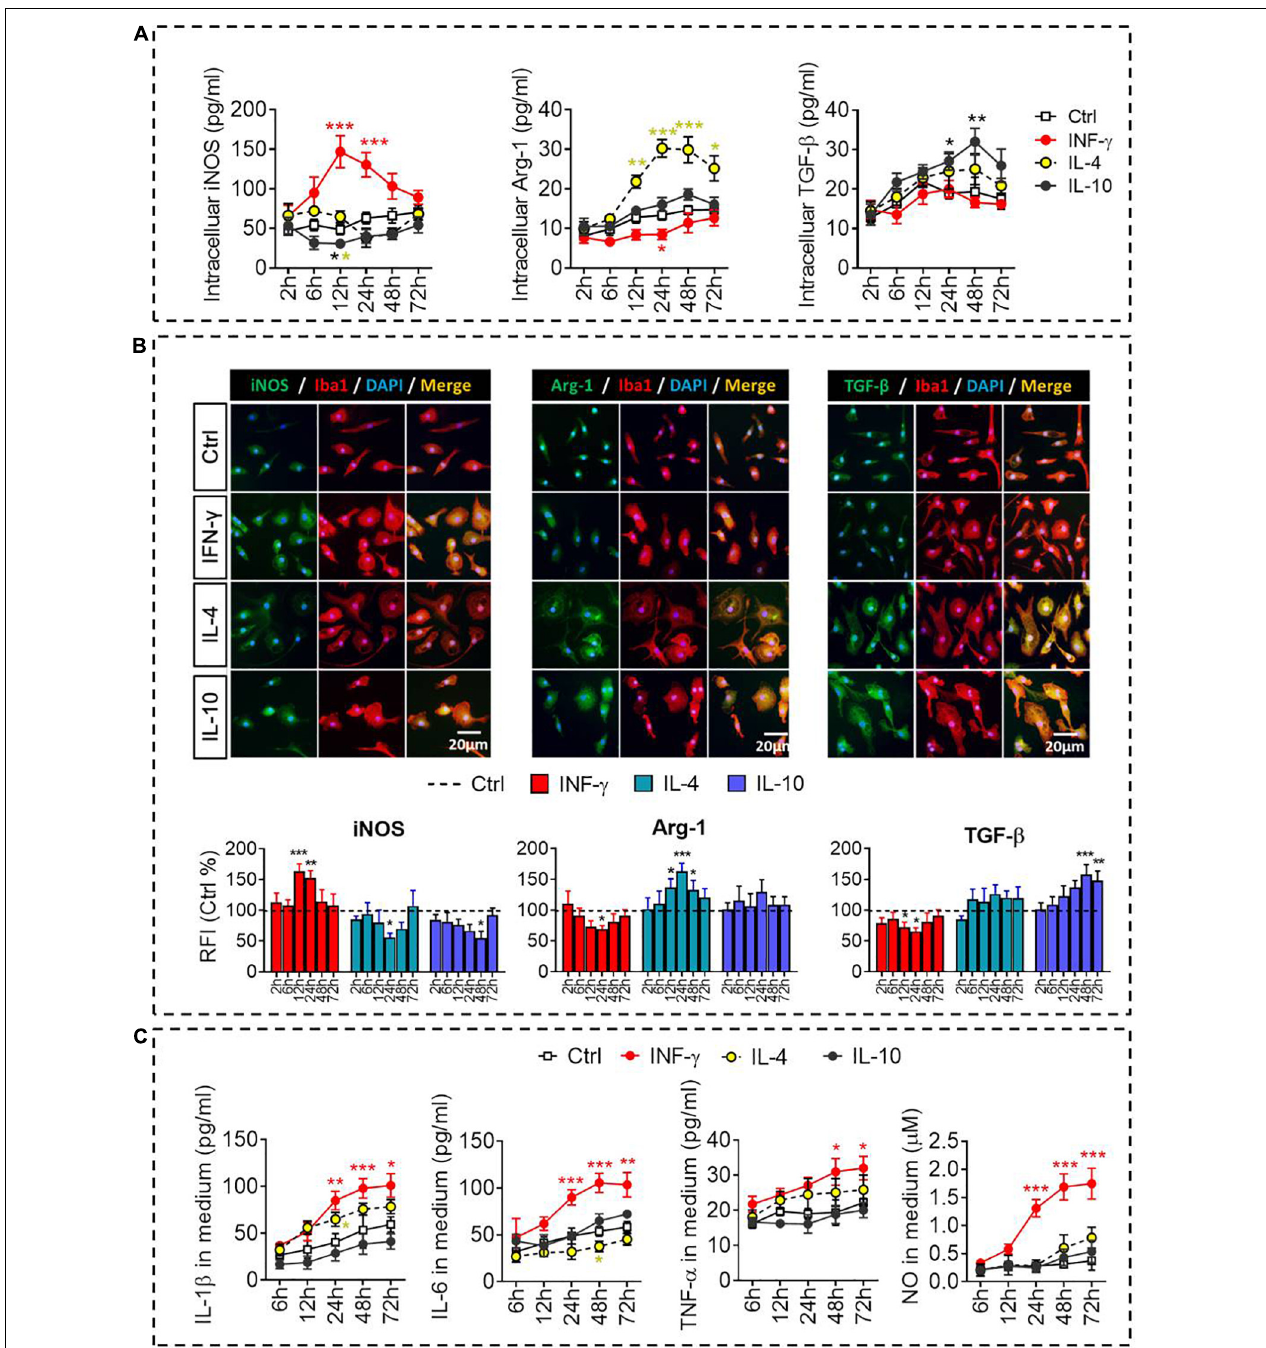
FIGURE 3 | Identification of intracellular and extracellular proteins in IFN- γ -, IL- 4-, or IL-10-stimulated microglia. (A) Quantification of the intracellular protein concentration of iNOS, Arg-1, or TGF- β following treatment with IFN- γ , IL-4, or IL-10 for 2–72 h. (B) Fluorescence micrographs of primary microglial cultures treated for 24 h with each of the cytokines and then immunostained for Iba1 as well as iNOS, Arg-1, or TGF- β . The histogram represent quantification of the relative fluorescence intensity (RFI) of iNOS, Arg-1 or TGF- β following treatment with IFN- γ , IL-4, or IL-10 for 2–72 h. The RFI were normalized with Ctrl group. (C) Quantification of the inflammatory mediators (IL- β , TNF- α , and IL-6) and toxic molecules (NO) in medium following treatment with IFN- γ , IL-4, or IL-10 for 2–72 h. Data are presented as mean ± SEM ( n = 4–6 well per group, three replicates per sample), * P < 0.05, ** P < 0.01, *** P < 0.005 (one-way ANOVA with Tukey’s multiple-comparisons